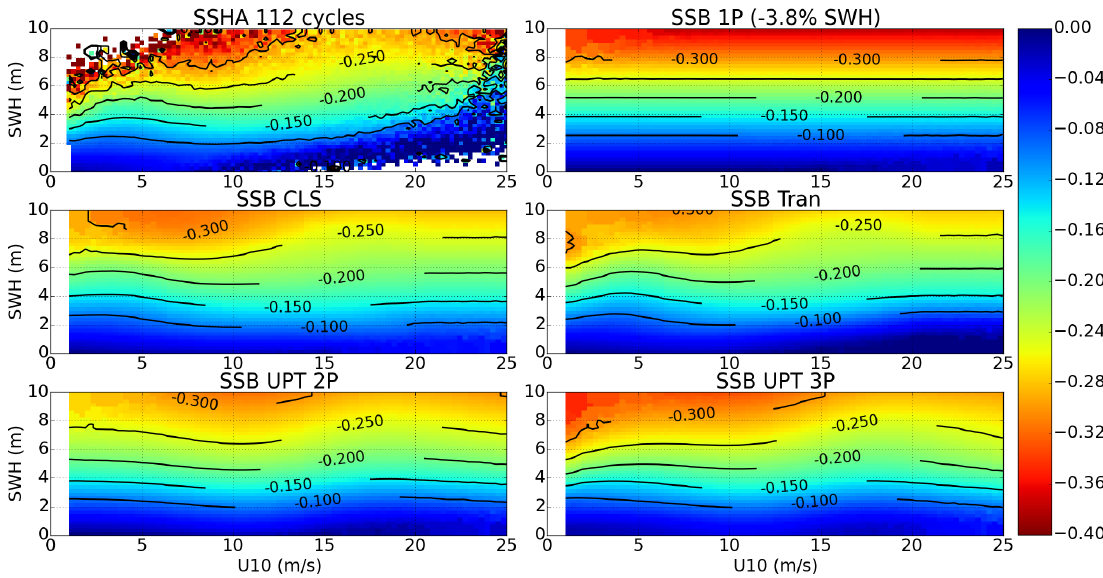
Figure 5. Training dataset of Sea Surface Height Anomaly (SSHA) (top left) and different SSB models outputs for SWH-U10 domain considering the same datataset. A linear empirical model using only one predictor computed by − 3.8% of SWH (top right), the two established SSB models (SSB CLS and SSB Tran on middle left and right, respectively) currently available in Jason-1 mission, and the two SSB models designed on this study (bottom left and